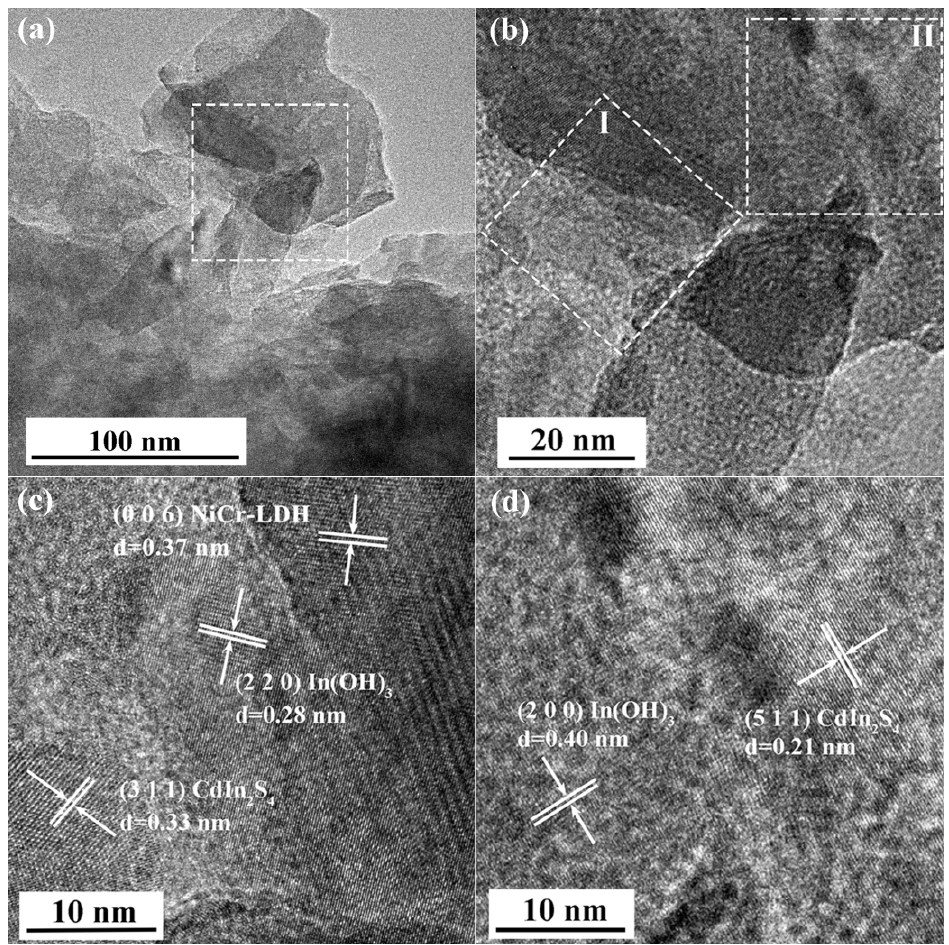
Figure 3. ( a , b ) TEM and ( c , d ) HRTEM images of HP-180, where c and d correspond to regions I and II, respectively.